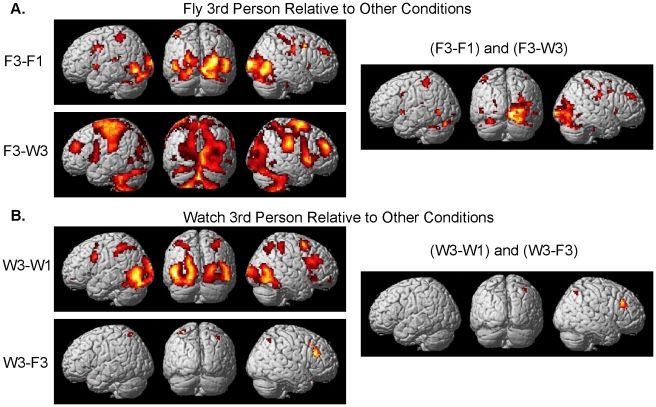
Brain activity specific to 3rd person flying and watching conditions. A. Random-effects results rendered on the normalized brain of the 3rd person flying condition relative to the other conditions as well as their conjunction (F3-F1) and (F3-W3) (pFDR <0.05 corrected for multiple comparisons). B. Random-effects results rendered on the normalized brain of the 3rd person watching condition relative to the other conditions as well as their conjunction (W3-W1) and (W3-F3) (pFDR <0.05 corrected for multiple comparisons).